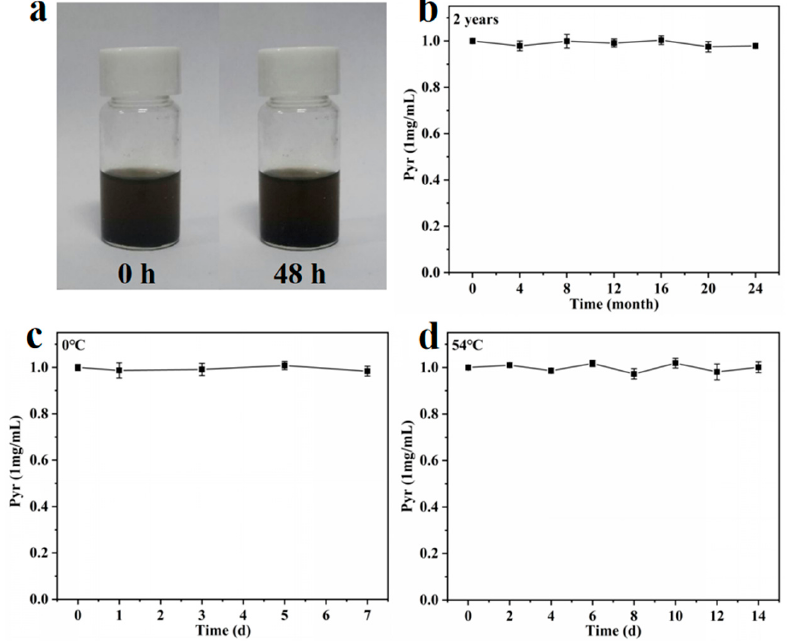
Figure 6. Storage stability of GO–Pyr nanocomposite. ( a ) Photos of GO–Pyr at 0 and 48 h, ( b ) stability of long-term storage, ( c ) storage stability under low temperature, and ( d ) storage stability under high temperature.